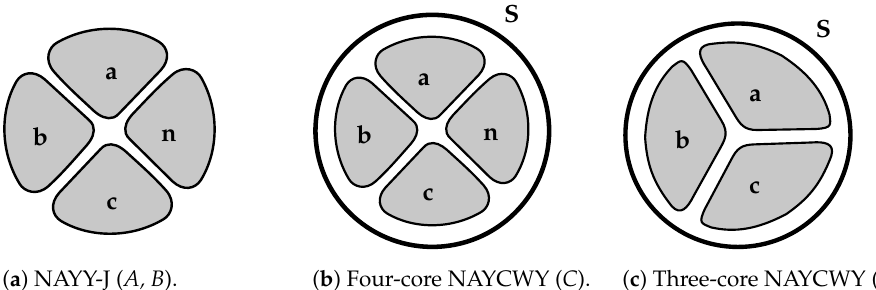
Figure 9. Ideal cable designs (corresponding test